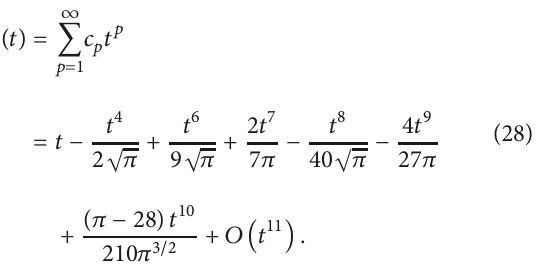
The coefficients 𝑐 𝑝 = 𝑝 −1 𝑑 𝑝−1 follow from the series 2 erf 𝑥 = ∑ ∞ 𝑑 𝑥 𝑝 , resulting in expansion 𝑒 −𝑥 𝑝 𝑝=0